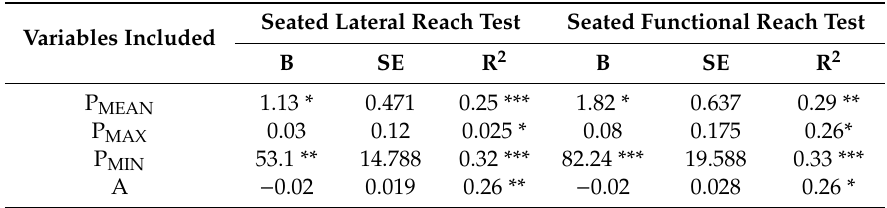
Table 3. Linear regression models for the Seated Lateral Reach Test and Seated Functional Reach Test (continuous